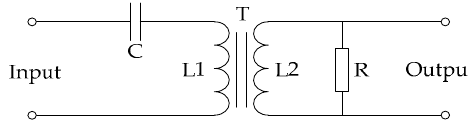
Figure 4. The HFT schematic.